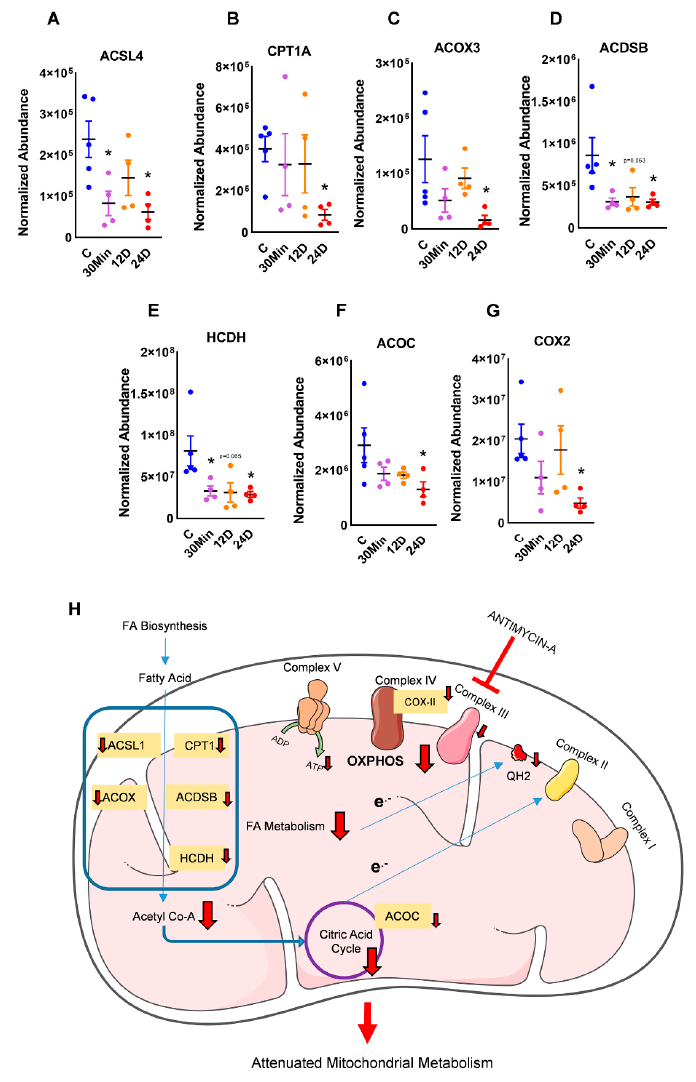
Figure 2. Complex III inhibition disrupted mitochondrial metabolism. Proteins in the fatty acid oxidation pathway: ( A ) carnitine palmitoyltransferase 1A (CPT1A), ( B ) acyl-CoA synthetase long